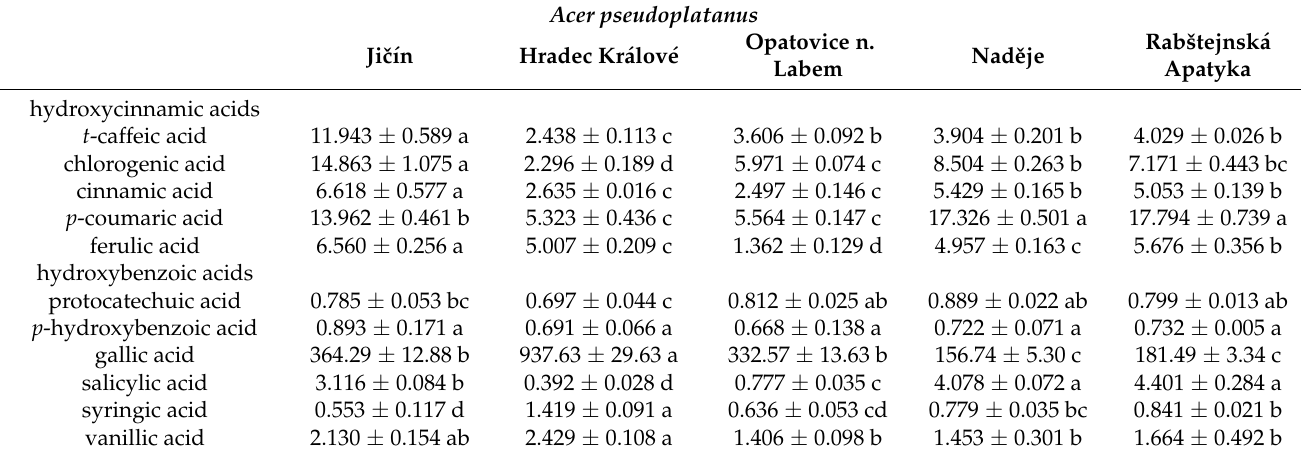
Table 2. The content of phenolic acids ( µ g g − 1 FW) in bud extracts of Acer pseudoplatanus . Values are expressed as mean ± SDs ( n = 5). Values within lines, followed by the same letter(s), are not significantly different according to Tukey’s test ( p < 0.05).